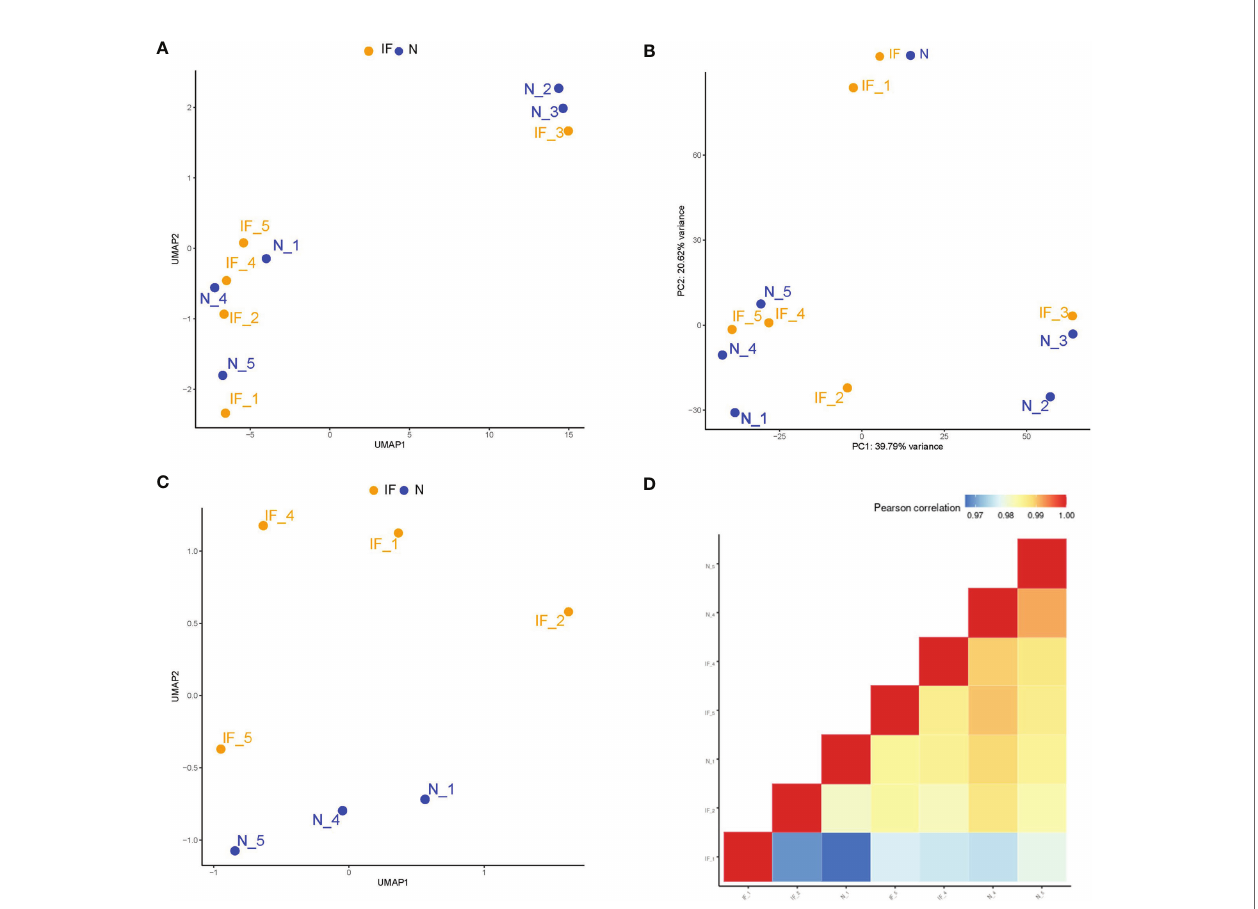
FIGURE 1 | Higher transcriptional heterogeneity acrossed the segmental region than that of the in fl ammatory conditions in the epididymides. (A) Sample distributions in a two-dimension space by UMAP based on global mRNA expression. IF represented the in fl amed epididymides, and N indicated the controls. (B) Sample distributions in a two-dimension space by the principal components analysis (PCA) based on global mRNA expression. (C) Distributions in two-dimension space by UMAP based on global mRNA expression after removing the corpus and cauda samples. (D) Correlation matrix of the remaining 7 samples by global mRNA expression of the caput